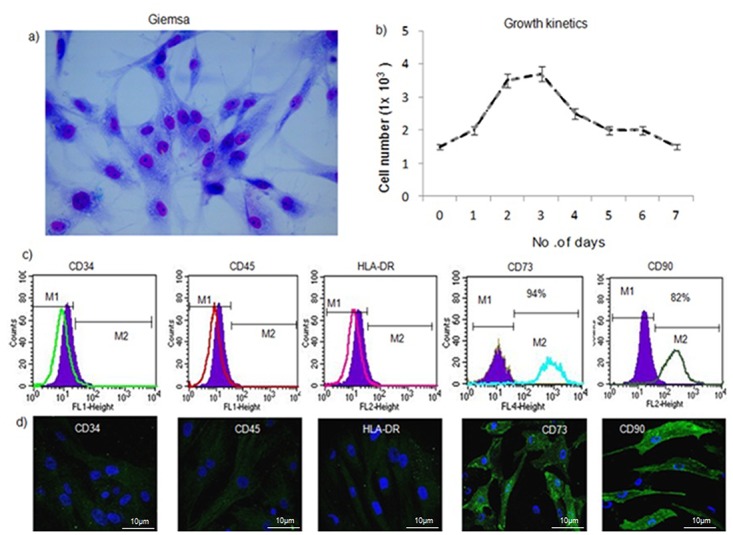
Characterization hADSCs cultures.a) Giemsa staining shows the spindle-shaped morphology of ADSCs. b) Growth curve obtained for the hADSCs (n = 5) shows an exponential growth phase. The cell number increased to 4x103cells/mL after 3 days. The decline phase started after 4 days and cell number was decreased to 1.3x103 cells/mL. c) Characterization of the following cell surface markers for hADSCs (n = 6) by flow cytometry: CD34-PE, CD45-FITC, HLADR-PE, CD90-FITC, and CD73-APC. The filled in histograms represent unstained negative control cells. CD34/45 markers were not expressed (0.2% and 0.3%, respectively), while low levels of HLADR expression (1.2%) were observed. hADSCs were positive for expression of CD90 (82%) and CD73 (94%), indicating a stem cell immunophenotype. d) Immunocytochemistry of hADSCs (n = 3): CD34/45and HLADR expression was negative, while CD90/CD73 expression was observed on the cell surface (shown in green).